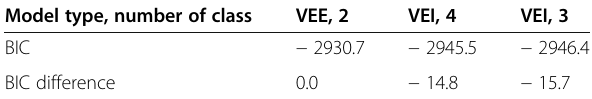
Table 3 Standardized factor loadings from the confirmatory factor analysis of the DCaT survey ( n = 166)